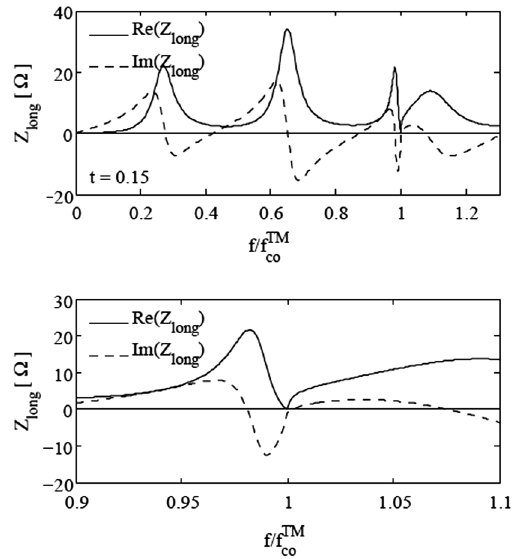
FIG. 13. Real part of the impedance for thickness t ¼ 15 cm. The different behavior at cutoff is clearly visible. b ¼ 5 cm, L ¼ 8 mm, σ ¼ 0 . 01 S=m